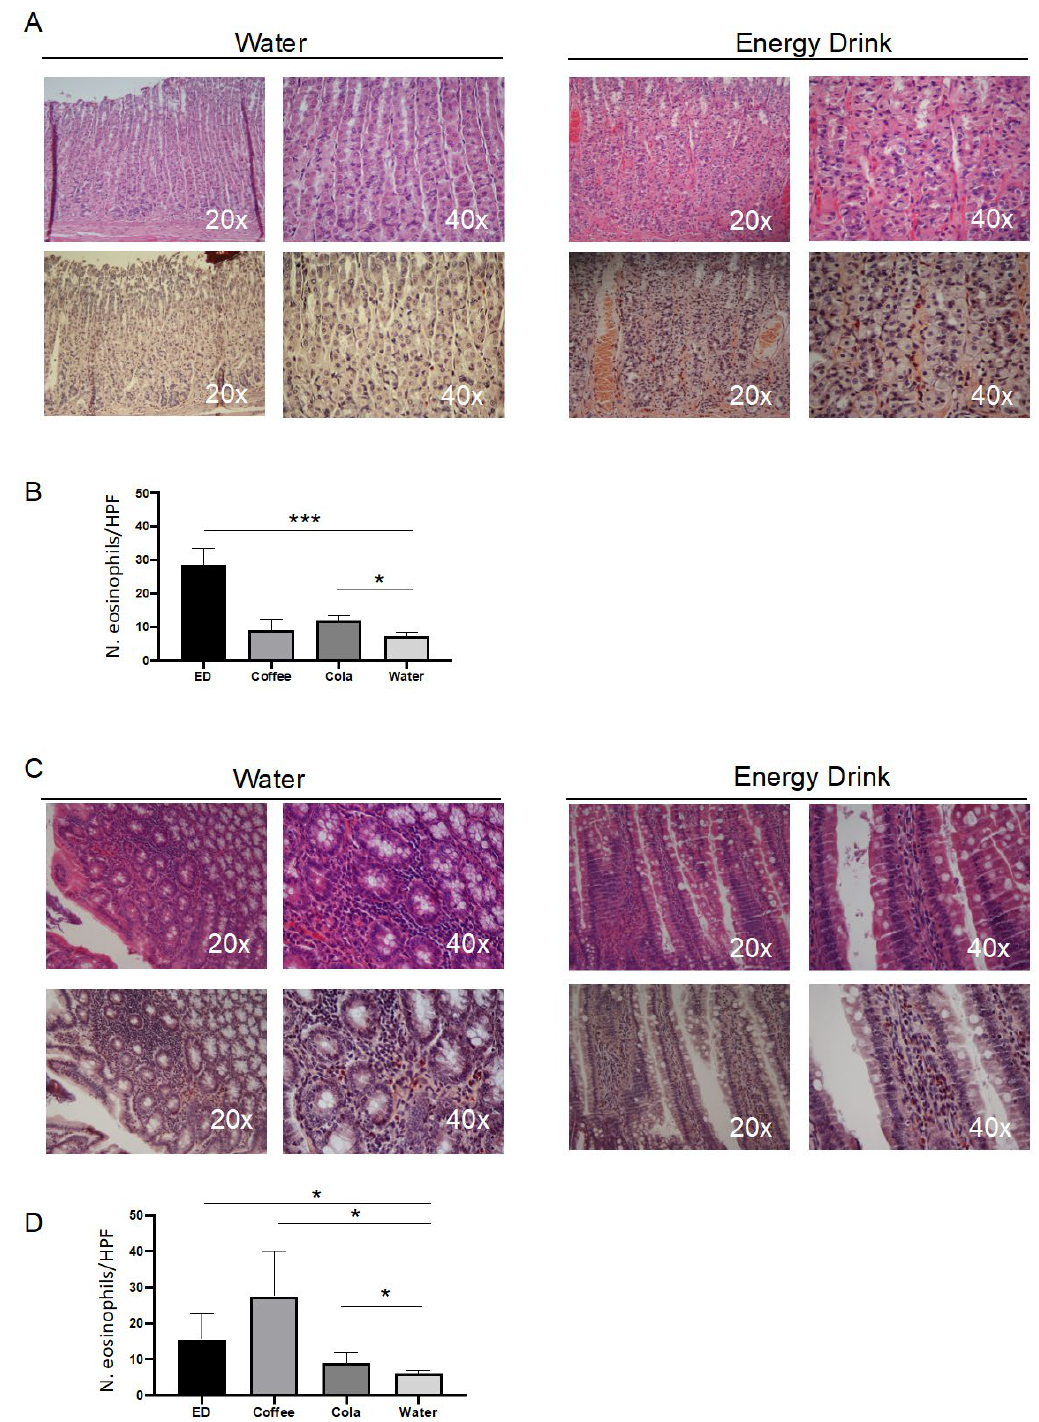
Figure 1. Energy drinks (ED) and coffee trigger eosinophilic infiltration in the mucosa of stomach and intestine in rats. ( A ). Representative histological staining of stomach sections from after 5 days with the indicated treatment. Upper panels: hematoxylin/eosin (H&E) staining; lower panels: Pagoda red staining. ( B ). Histogram showing the number of eosinophils per high-powered field (HPF) after five days of the indicated treatment. Data are mean ± SD of ten different counts. ( C ). Representative histological staining of small intestine sections from after 5 days with the indicated treatment. Upper panels: H&E staining; lower panels: Pagoda red staining. ( D ). Histogram showing the count of eosinophils per HPF after five days of the indicated treatment. Data are median ± interquartile range of ten different counts. * p < 0.05; *** p < 0.001